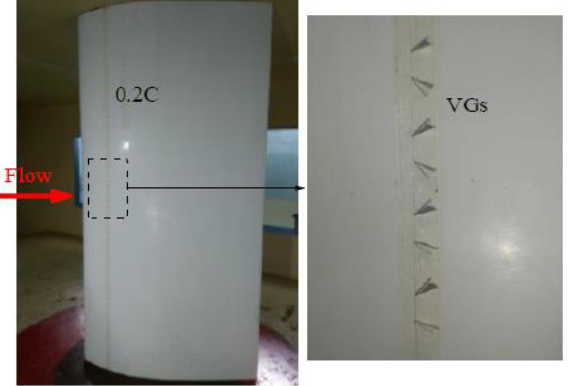
Table 4. VG geometric parameters and arrangement.